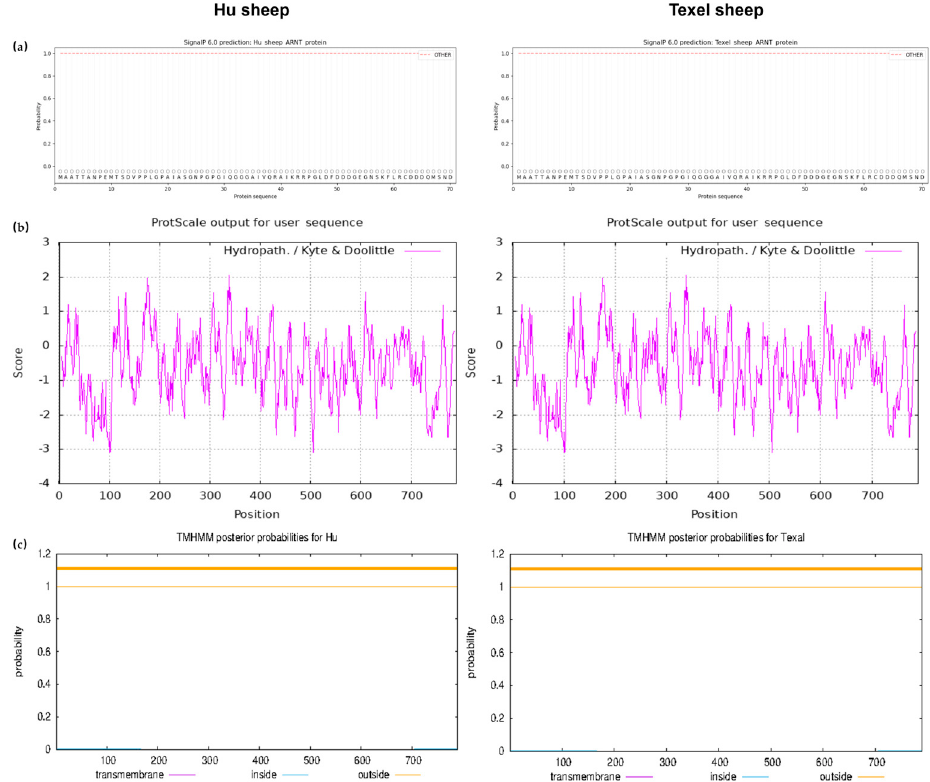
Figure 4. ARNT protein structure and property prediction: ( a ) Signal peptide prediction in Hu and Texel sheep, ( b ) Hydrophilic and hydrophobic prediction, ( c ) Prediction of transmembrane helices.